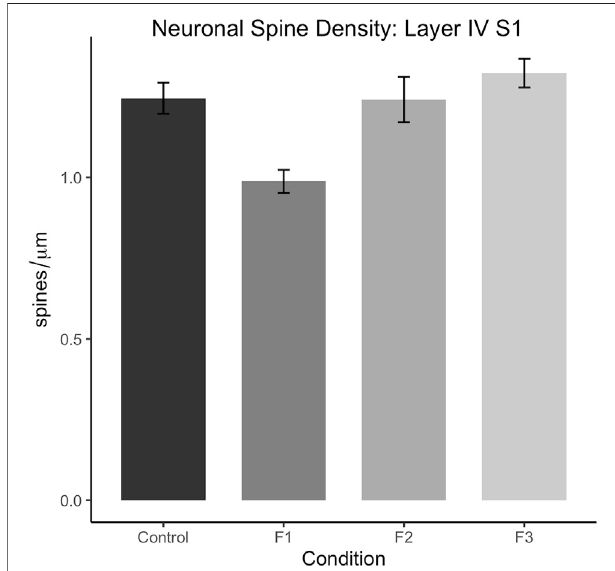
FIGURE 9 | Dendritic spine density analysis in layers IV of spiny stellate neurons in S1 at P20. Spine density (spines/µm) is signi fi cantly decreased in S1 spiny stellate cells of F1 mice compared to cells of control mice ( p < 0.01). Neurons of F2 and F3 mice display no signi fi cant differences in dendritic spine density compared to